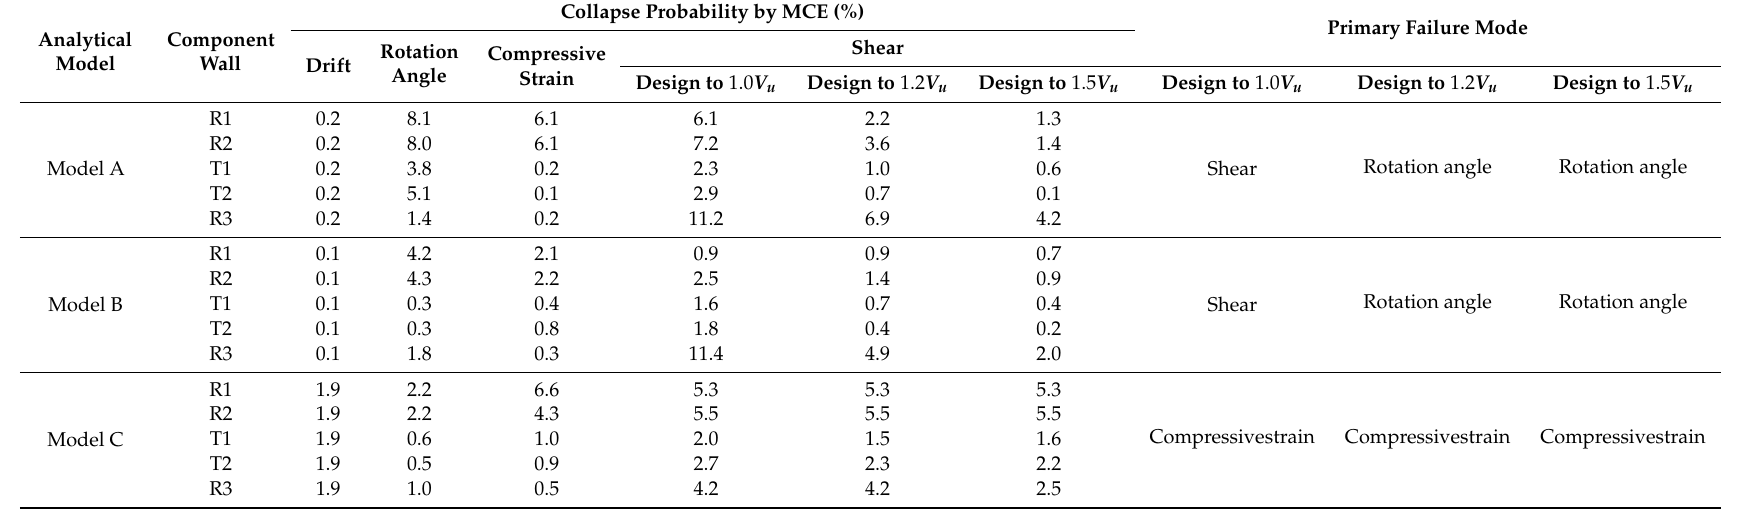
Table 13. Primary failure mode by analysis